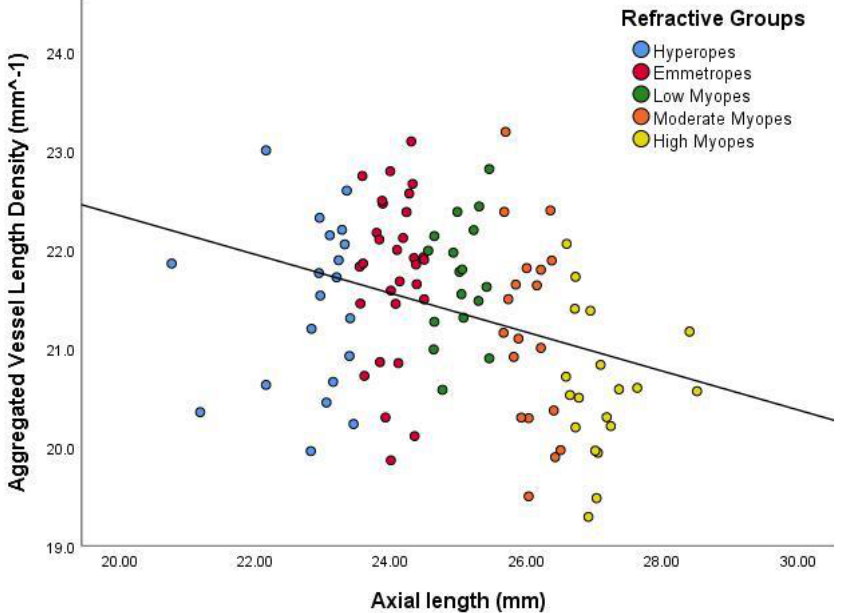
Figure 3. Scatter plot demonstrating the relationship between aggregated vessel length density and axial length. The colours distinguish the subjects for their particular eye size bin. The regression line indicates a significant inverse relationship (r 2 = 0.102, p < 0.001).